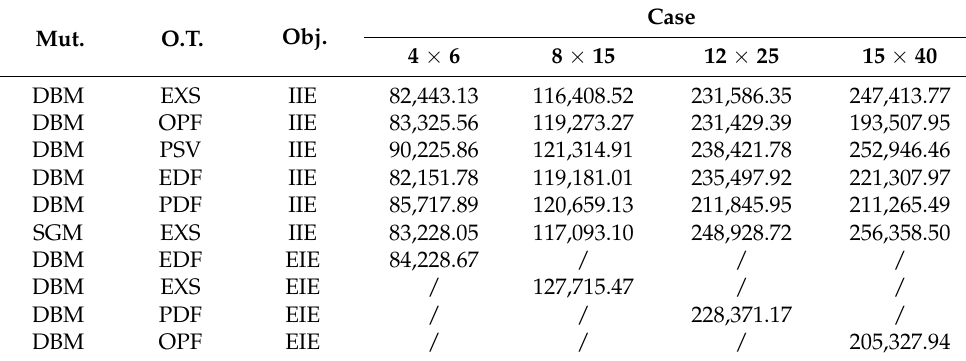
Table 7. Mean PC obtained by replicated configuration experiments. Mut.